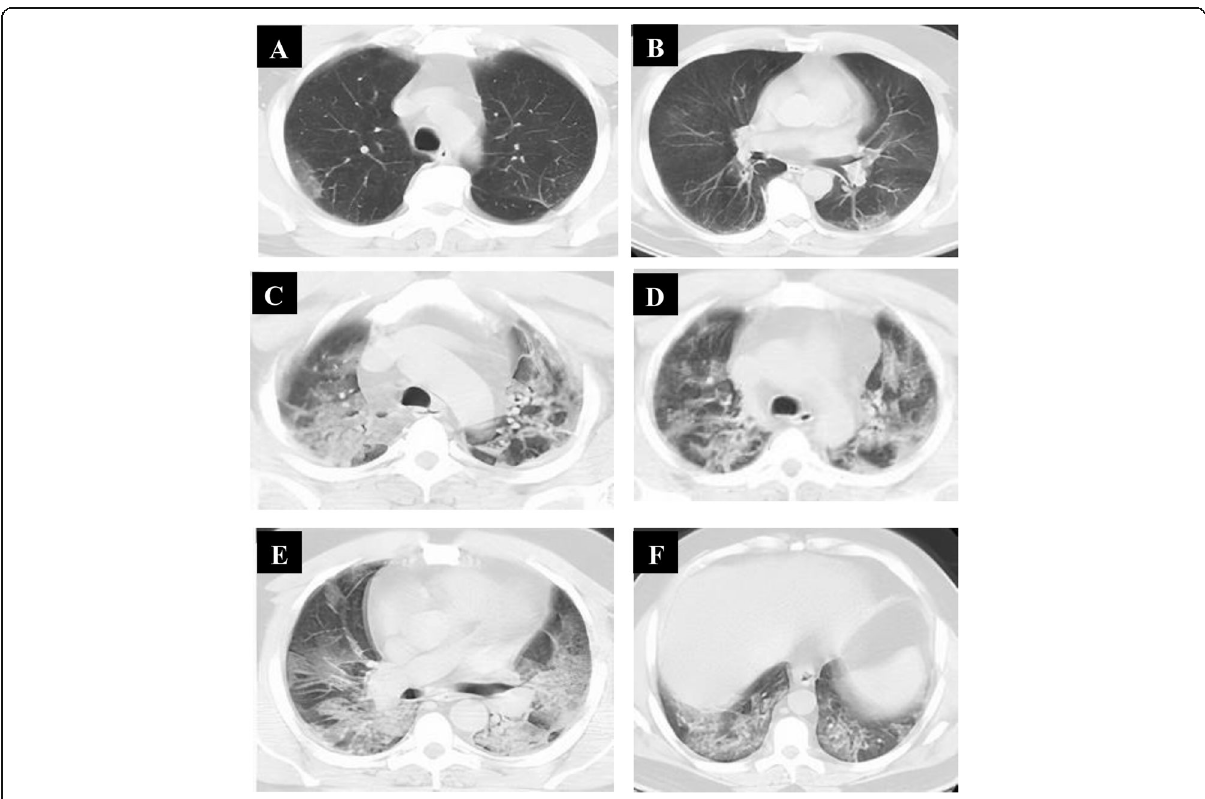
Fig. 6 A 42-year-old female patient complaining of diarrhea and cough (mild symptoms). Non-contrast axial chest CT ( a , b ) 2 days from onset of symptoms (early phase) revealed few patchy areas of ground-glass opacities and consolidation seen at basal segments of both lungs lower lobes: peripheral in distribution. With the progression of symptoms (developed dyspnea), follow-up chest CT ( c – f ) 6 days from onset of symptoms revealed more extensive lesions in form of multiple confluent patchy areas of ground-glass opacities, consolidation, and crazy-paving seen scattered at both lungs: central and peripheral in